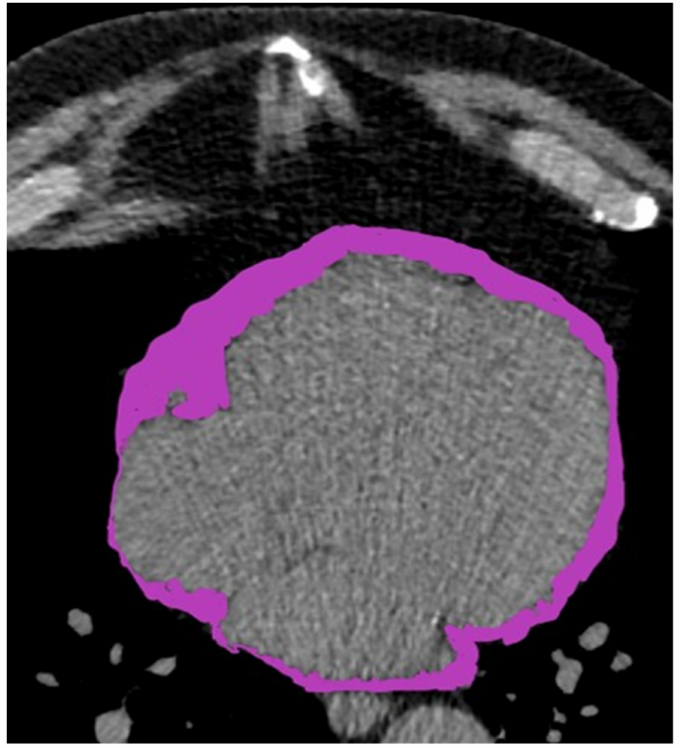
Figure 1. Extended pericardial adipose tissue in a smoker. PAT volume was 253